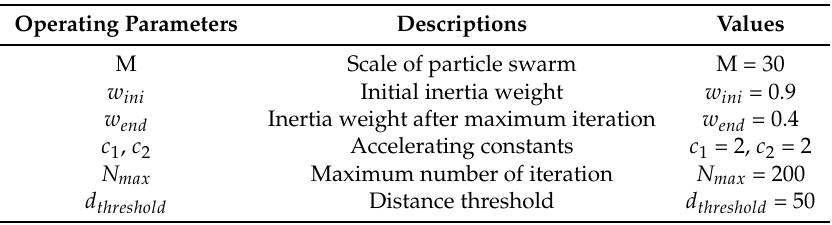
Table 1. Initializing the parameters for PSO-based image-block